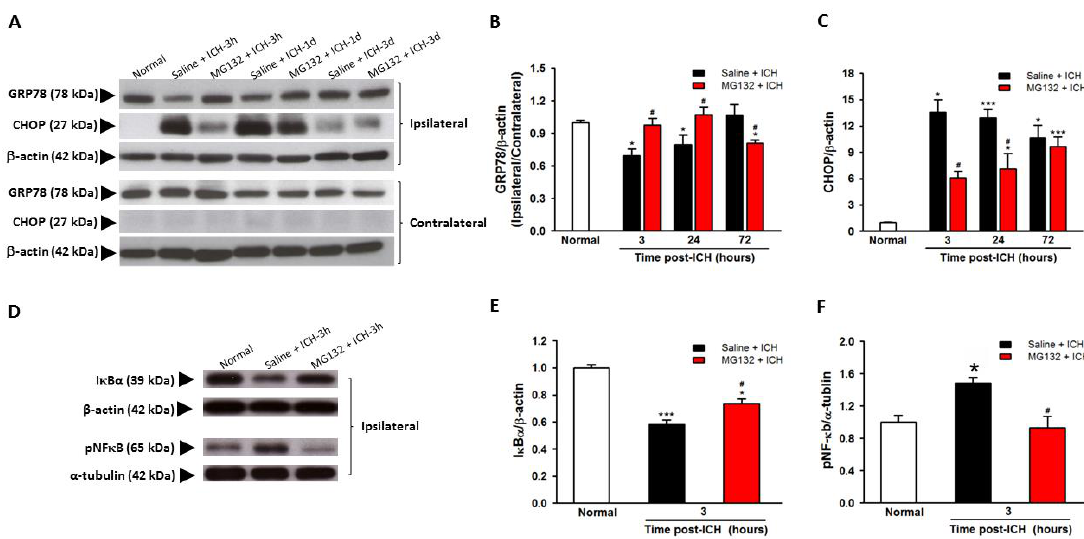
Figure 5. E ff ects of MG132 pretreatment on GRP78, CHOP, I κ B, and pNF- κ B protein levels after ICH injury. Representative Western blotting images showing the 78-kDa band of GRP78, 19-kDa band of CHOP ( A ), and pNF- κ B, and I κ B ( D ). Quantitative analyses of GRP78 ( B ) and CHOP ( C ) protein detected in the ipsilateral and contralateral striatum lysate from normal, Saline + ICH-3h, MG132 + ICH-3h, Saline + ICH-24 h, MG132 + ICH-24h, Saline + ICH-72h, and MG132 + ICH-72h animals, respectively. Quantitative analyses of I κ B ( E ) and pNF- κ B ( F ) protein detected in the ipsilateral striatum lysate from normal, Saline + ICH-3h, and MG132 + ICH-3h animals, respectively. Values are indicated by means ± SEM; n = 6 each group, * p < 0.05; *** p < 0.001; compared to the normal group; # p < 0.05; compared to the Saline + ICH group, respectively.